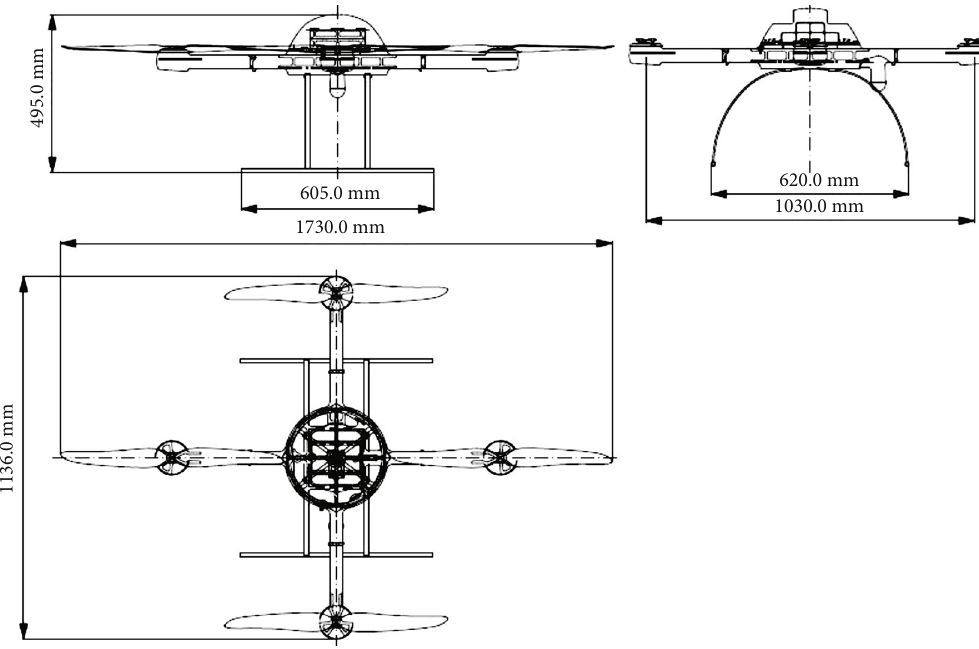
Figure 9: Computer-Aided Design (CAD) model of the Q-UAV used for the case study. Table 3: Main operational parameters of the